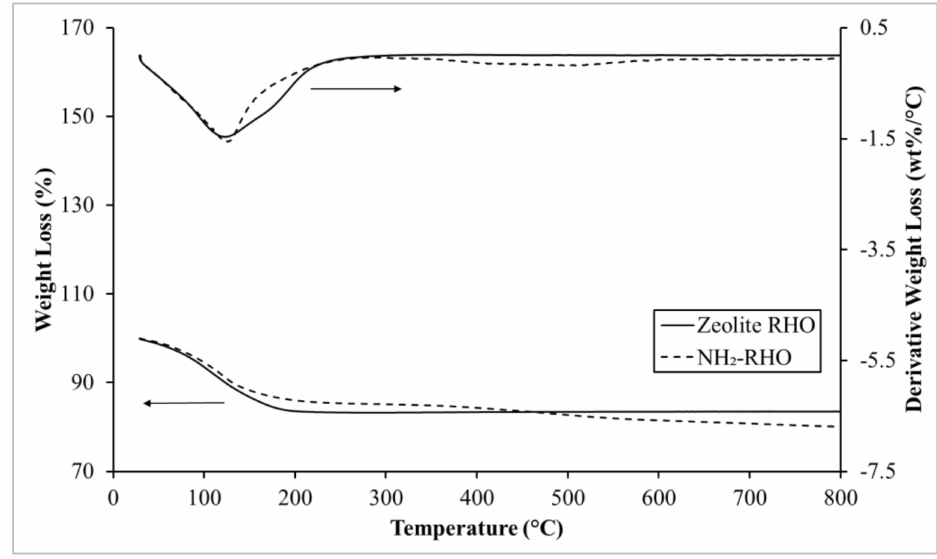
Figure 7. TGA-DTG thermograms of zeolite RHO and NH 2 -RHO.